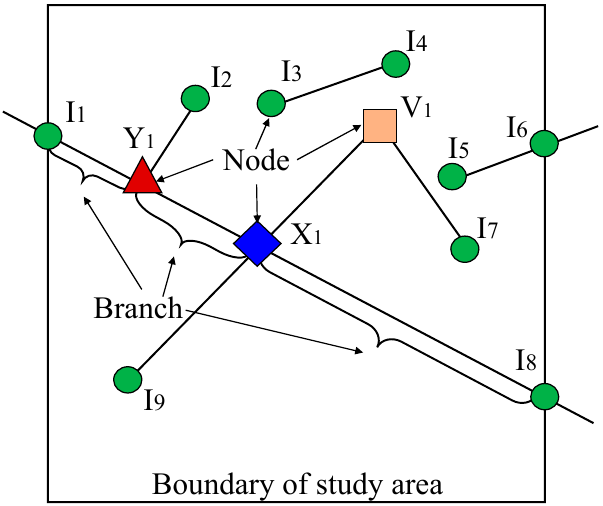
Figure 1. Classification of nodes and branches in a fracture network.